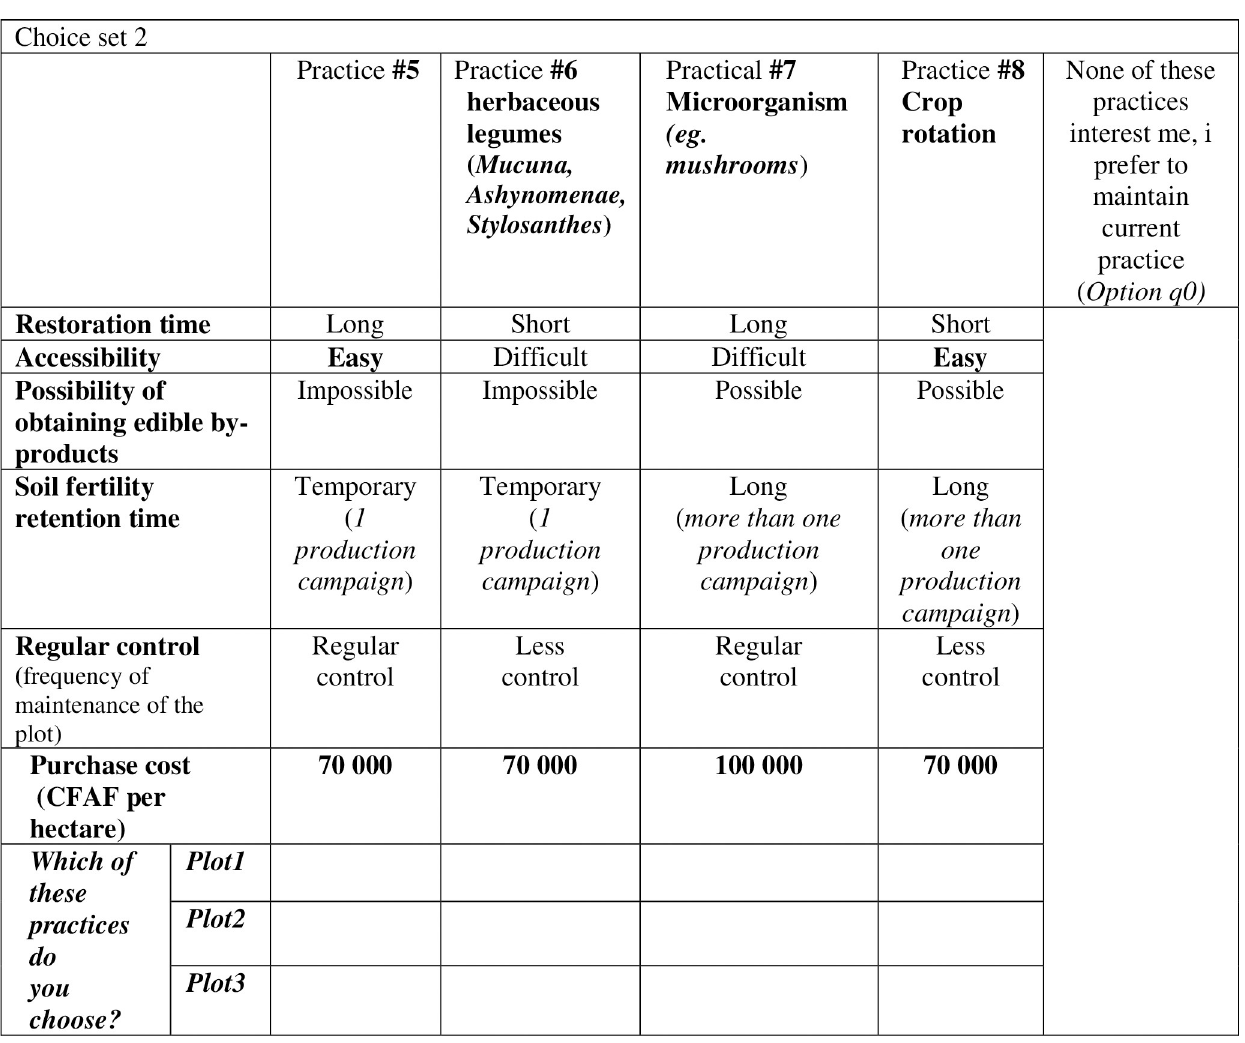
Fig 2. Example of a set of cards proposed during the